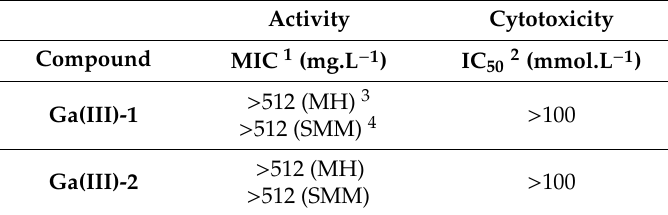
Table 4. Antipseudomonal activities and cytotoxicity of Ga(III)-1 and Ga(III)-2.